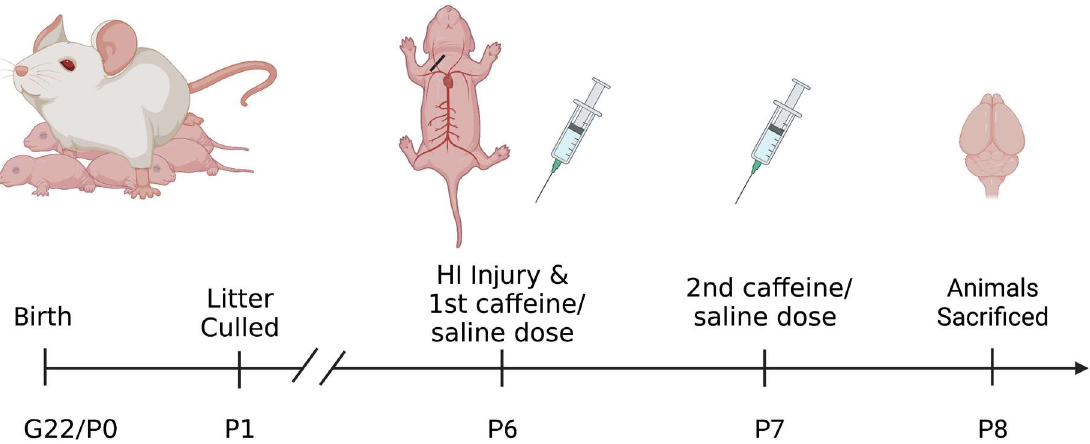
Figure 1. Diagram of the experimental design shown in a timeline from subject birth to sacrifice. Following sacrifice brains were collected and sectioned for staining. Created with BioRender.com